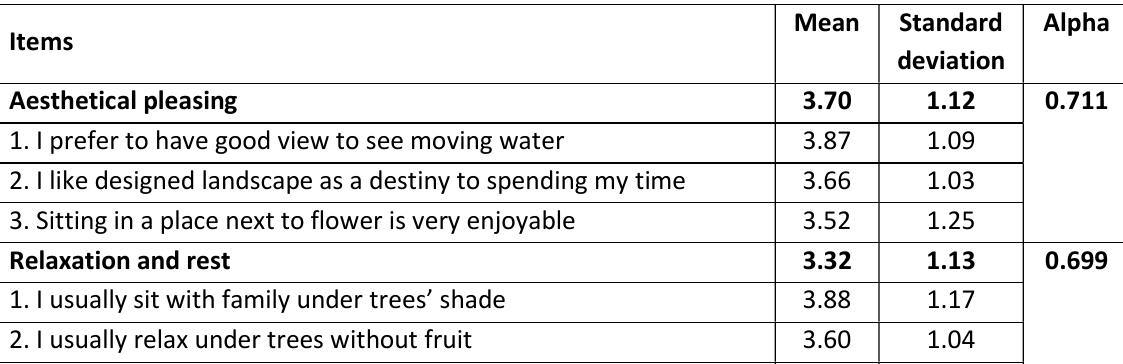
Table 2: Public Preferences for Activities in Park